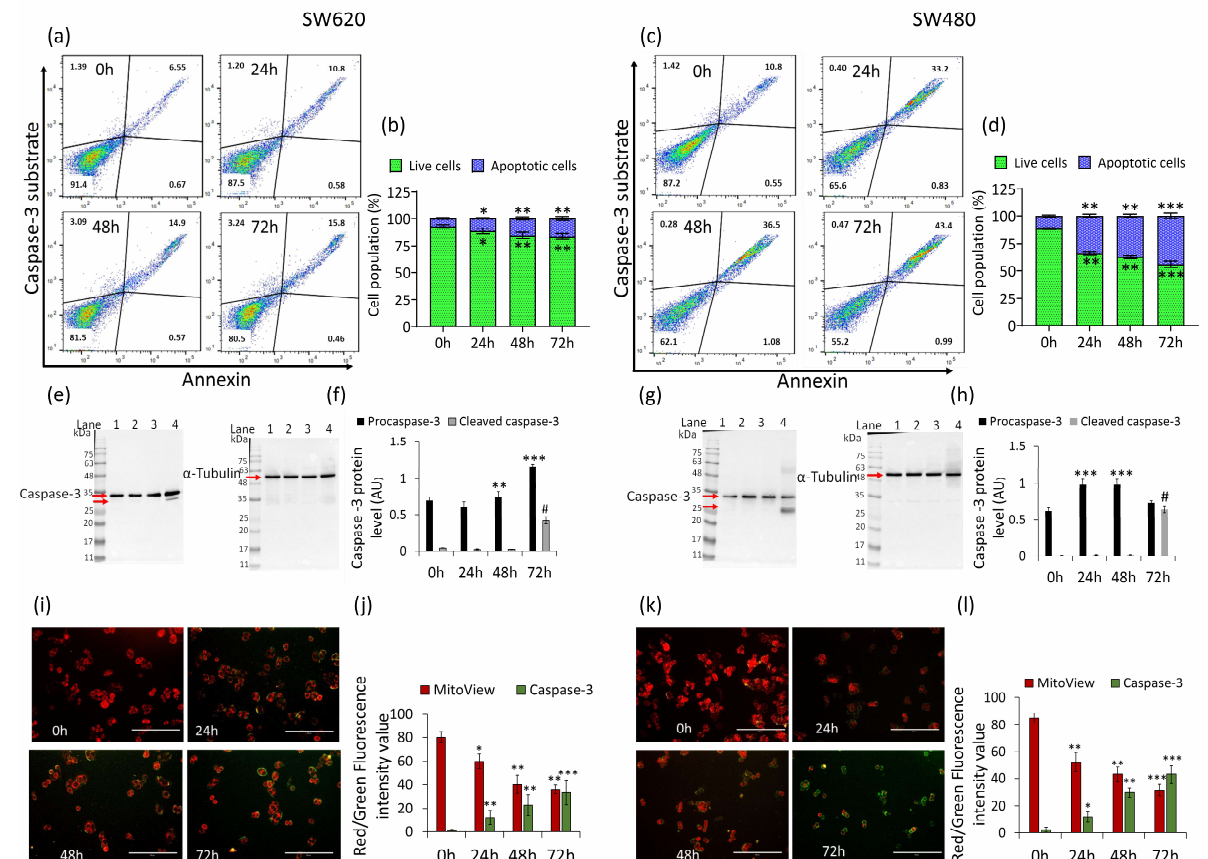
Figure 3. Effects of δVB on caspase-3 activation. Representative dot plots and analyses of caspase-3 activation by reporting annexin CF 594 and caspase-3 substrate on ( a , b ) SW620 and ( c , d ) SW480 cells treated with δVB (1.5 mM) at 24, 48 and 72 h. Cell population was assessed by flow cytometry and results expressed as % of live or apoptotic population with mean ± SD of n = 3 experiments. At least 10,000 events were acquired. Representative full-length blots of Western blotting analysis of caspase-3 in ( e , f ) SW620 and ( g , h ) SW480 cells. Lane 1 = 0 h; lane 2 = 24 h; lane 3 = 48 h; lane 4 = 72 h. Before lane 1, molecular weight markers (G266, Applied Biological Materials Inc., Richmond, BC, Canada). Protein expression was calculated, after normalization with α-tubulin as internal control, with ImageJ software and results expressed as arbitrary units (AU). Representative images and analysis of Nucview 488 and Mitoview 633 staining of ( i , j ) SW620 and ( k , l ) SW480 cells analyzed by fluorescence microscopy. Results expressed as red and green fluorescence intensity value. Scale bar: 100 μm. * p < 0.05 vs. Ctr; ** p < 0.01 vs. Ctr; *** p < 0.001 vs. Ctr; # p < 0.0001 vs. Ctr.